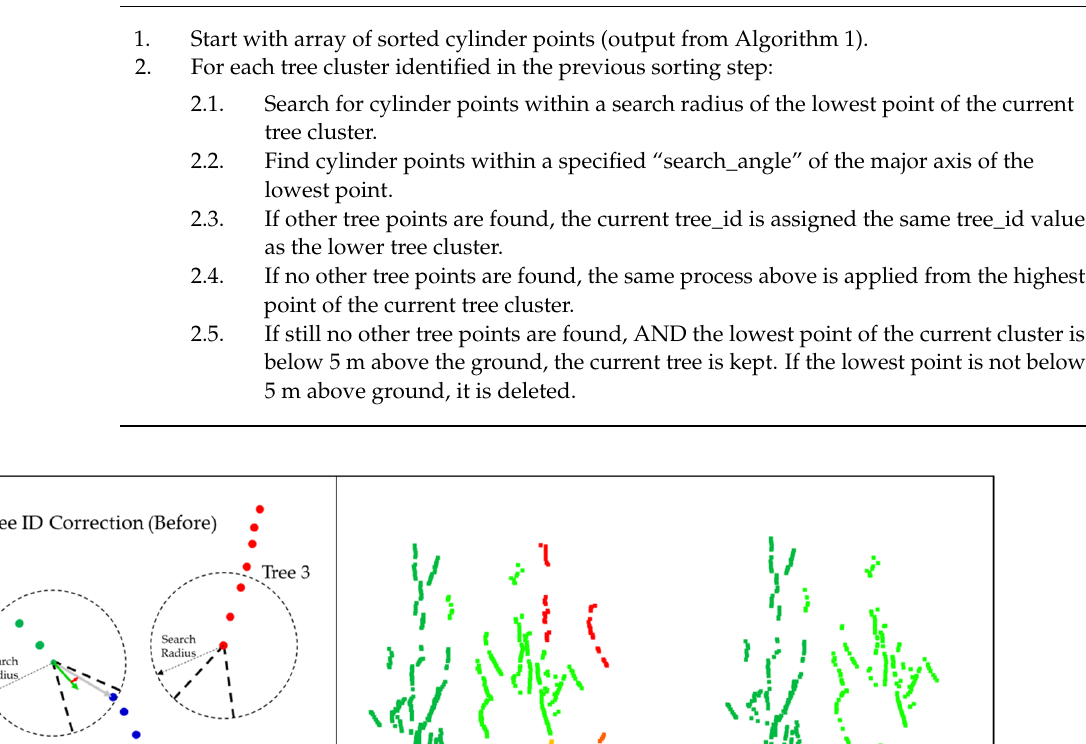
Algorithm 2. Cylinder Sorting Algorithm Part 2